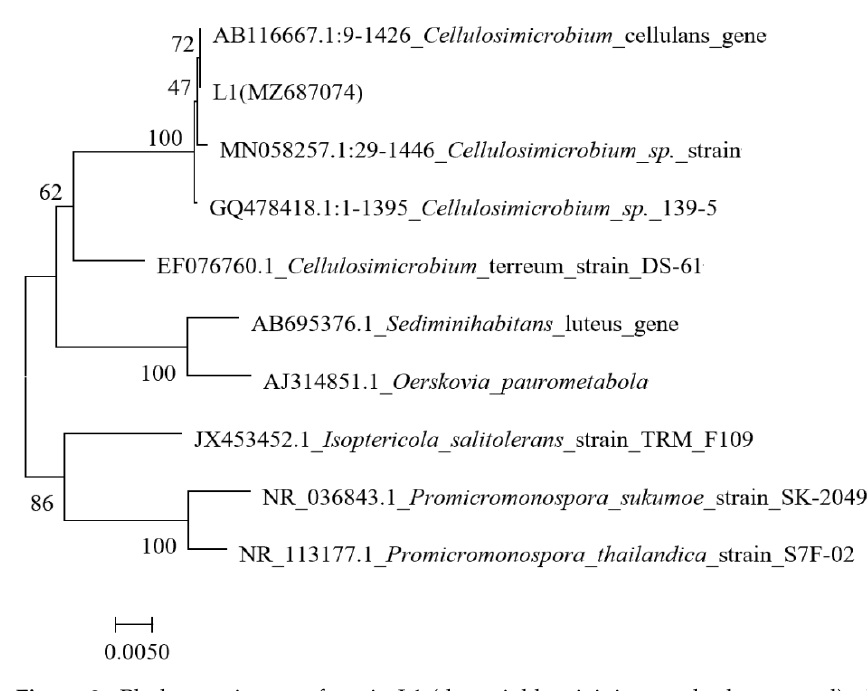
Figure 4. Effect of different carbon nitrogen sources on enzyme conversion activity: ( a ) carbon source, ( b ) sucrose concentration, ( c ) nitrogen source, ( d ) NH 4 Cl concentration. The different letters indicate significant differences ( p < 0.05) between each group.